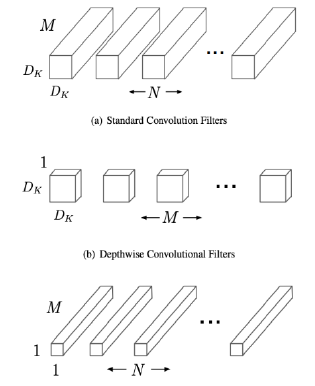
Fig. 3. Standard convolutional filters and depthwise separable filters. (a) Standard convolutional filters, (b) depthwise convolutional filters, and (c) point convolutional